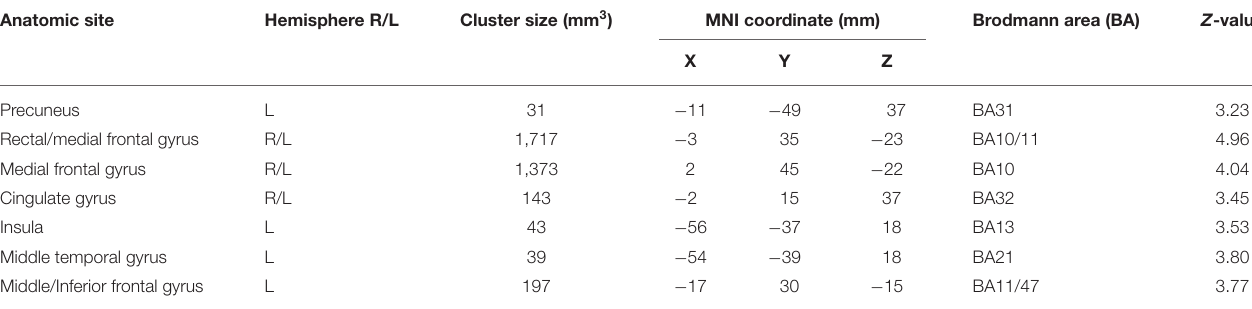
TABLE 4 | Regions of decreased GMV in SCH compared to controls (control > SCH).